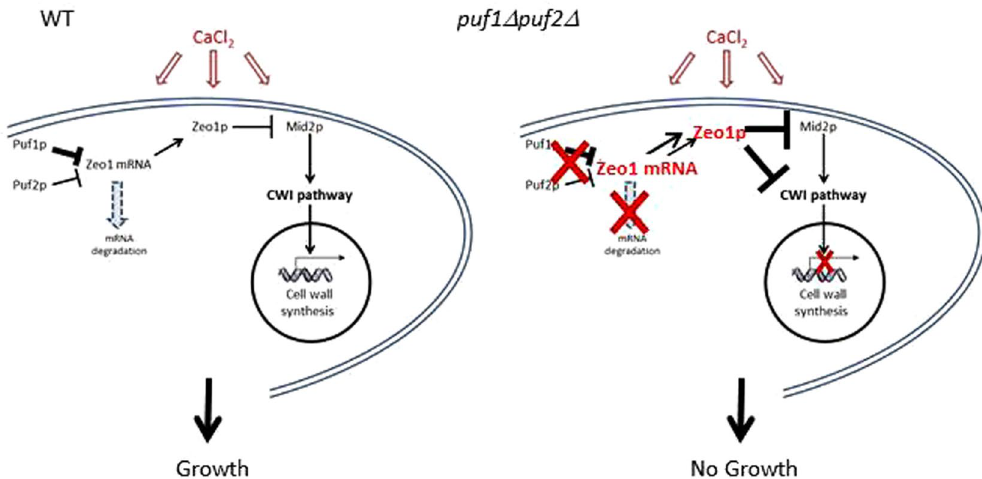
Figure 9. Model for cellular regulation upon CaCl 2 stress. High concentration of CaCl 2 activates Puf1p and Puf2p proteins. These maintain low levels of Zeo1 mRNA, most likely by inducing its degradation. Thus, Zeo1 protein levels are low and its known repressive effect on the Cell Wall Integrity (CWI) pathway 40 is excluded. This permits proper transcriptional response to the stress. In strains deleted of Puf1p and Puf2p (right panel), Zeo1 mRNA levels are high, hence an increase in Zeo1 protein levels and inhibition of the CWI pathway. This leads to improper transcriptional response and the observed growth